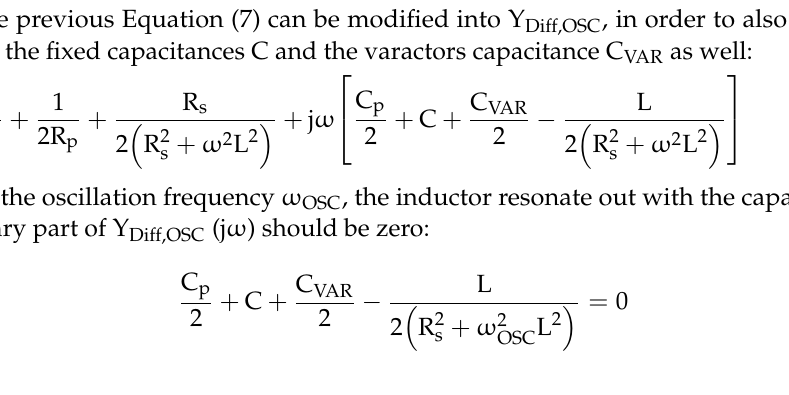
Figure 6. Tuning characteristics of the varactor (on the left ) and of the VCO (on the right